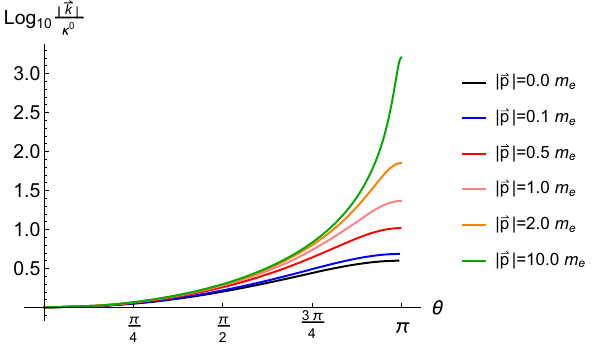
Fig. 3 Relationship between the energy of the emitted ALP and the polar angle at which it is emitted in lab frame. These plots are for